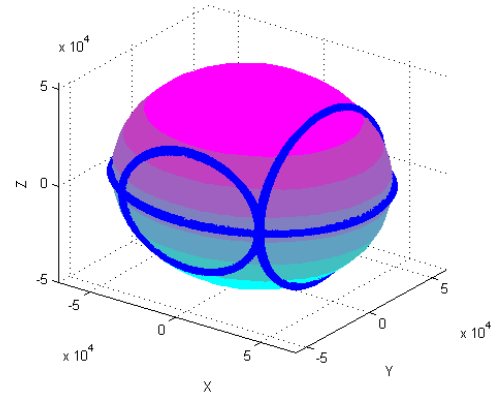
Figure 8. Optimal ellipsoid fitting (EF5). Figure 9. Optimal ellipsoid fitting (EF6).